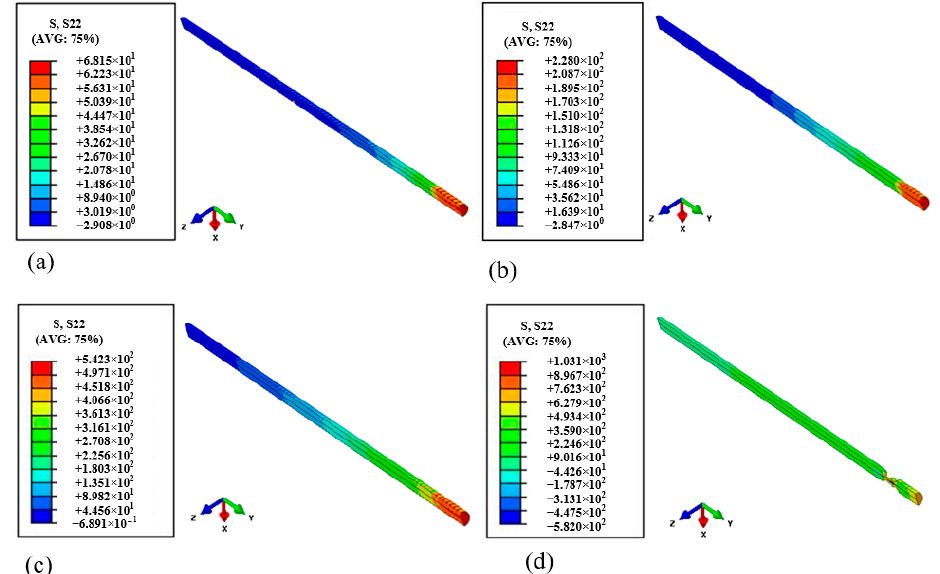
Figure 13. Stress nephogram of GFRP bolt with anchor length of 840 mm: ( a ) F = 40 kN, ( b ) F = 120 kN, ( c ) F = 240 kN, ( d ) after bolt pull-out.